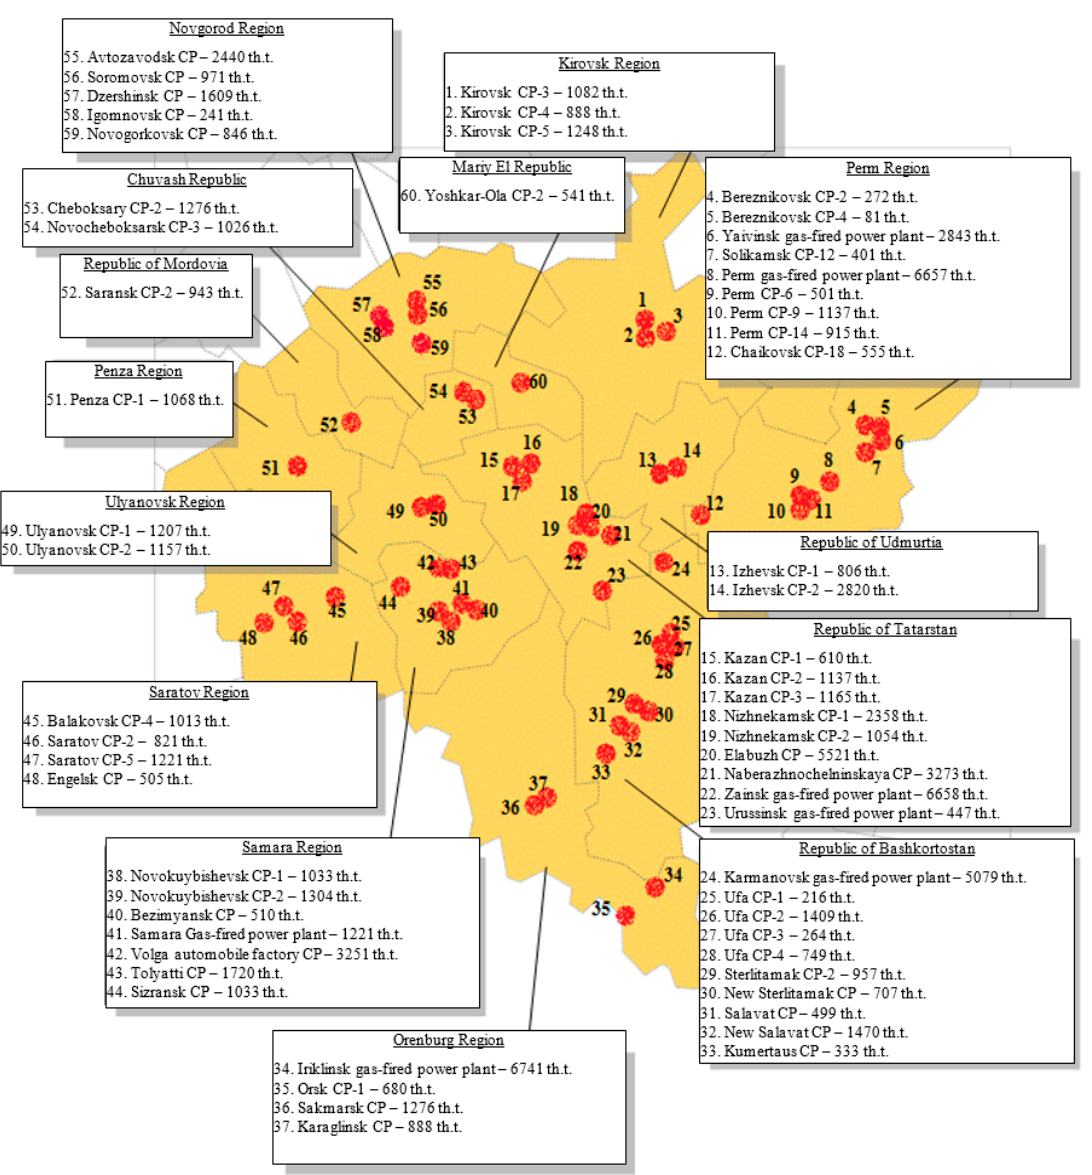
Figure 11. Map of combined heat and power plants (CP) of the Volga Federal District.